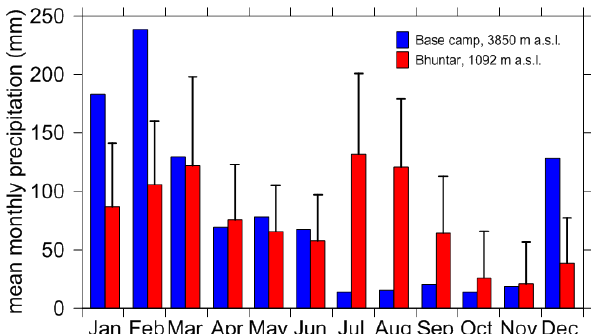
Figure 5. Comparison of monthly precipitations (blue bars) at Chhota Shigri base camp for 2012/2013 hydrological year with the mean monthly precipitations (red bars) between 1969 and 2013 at Bhuntar meteorological station. The error bars represent the stan- dard deviation (1 σ ) of the monthly precipitation